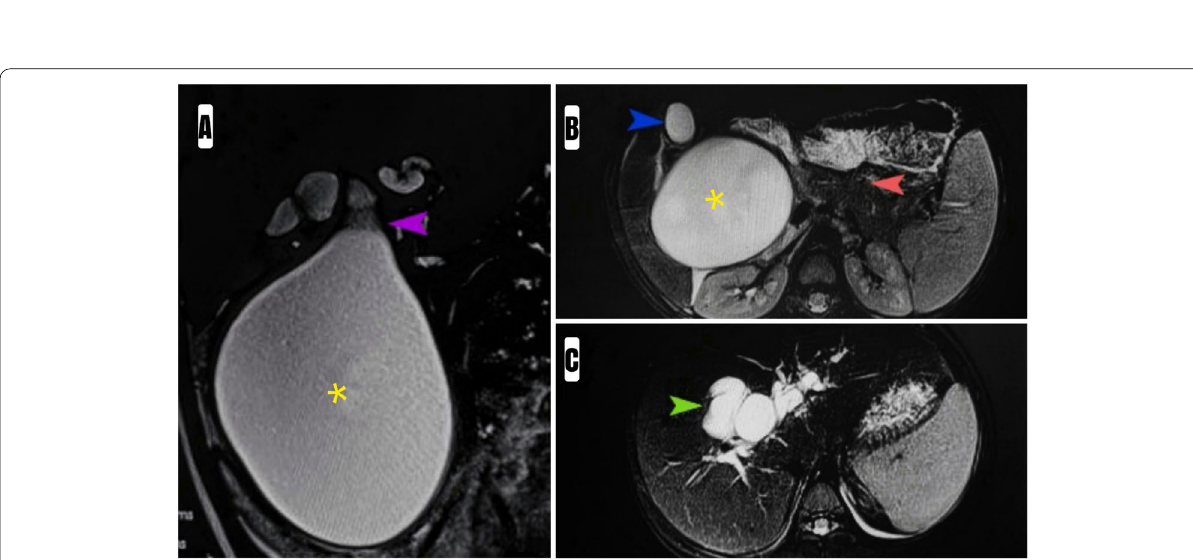
Fig. 2 A – C : Preoperative MRCP ( A and B ) showing a cysticly dilated common hepatic duct (purple arrowhead) and CBD (yellow asterisk). The main pancreatic duct (red arrowhead) and GB (blue arrowhead) are unremarkable. ( C ) Dilated bilobar central and peripheral intrahepatic biliary radicles (green arrowhead) are present. No T2-weighted hypointense filling defect was seen in the